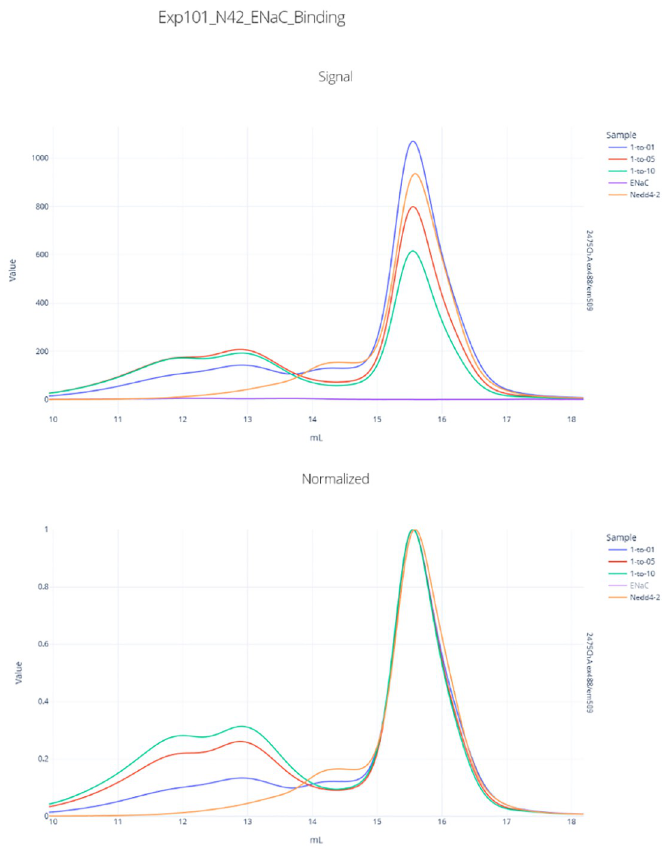
Fig 6. ENaC αβγ /NEDD4-2 binding. Top: raw GFP fluorescence from NEDD4-2-GFP fusion protein. Bottom: fluorescence signal normalized, setting free NEDD4-2-GFP peak height to 1.